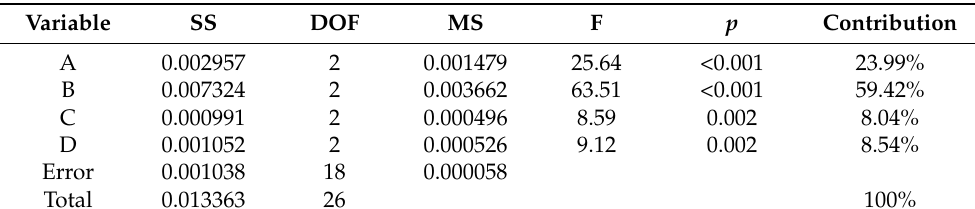
Table 6. ANOVA result for the thermal conductivity.